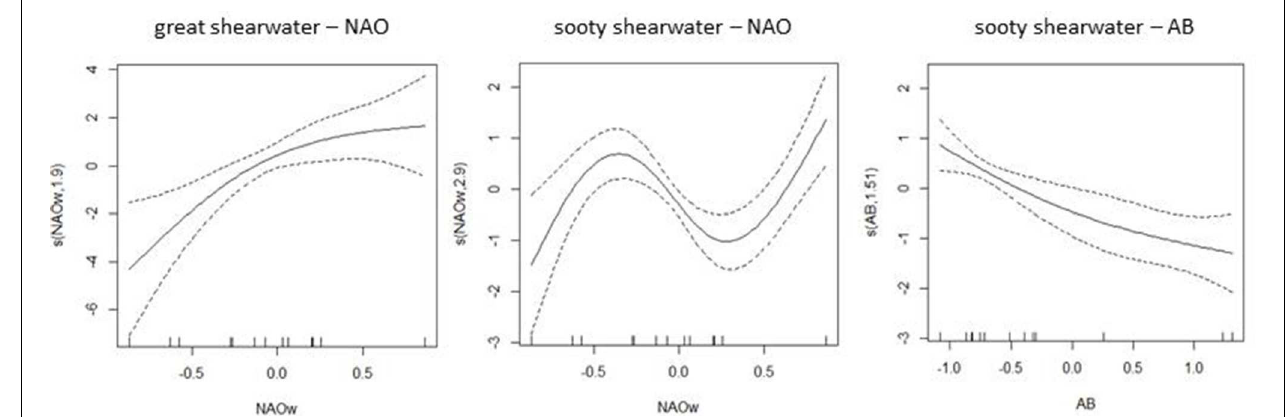
FIGURE 5 | Smooth functions fitted to the best relationships between great and sooty shearwater abundance and environmental variables: NAO winter index (December to March) and less importantly the anchovy biomass estimation (AB). Models were first ordered by the AICc value and among equivalent